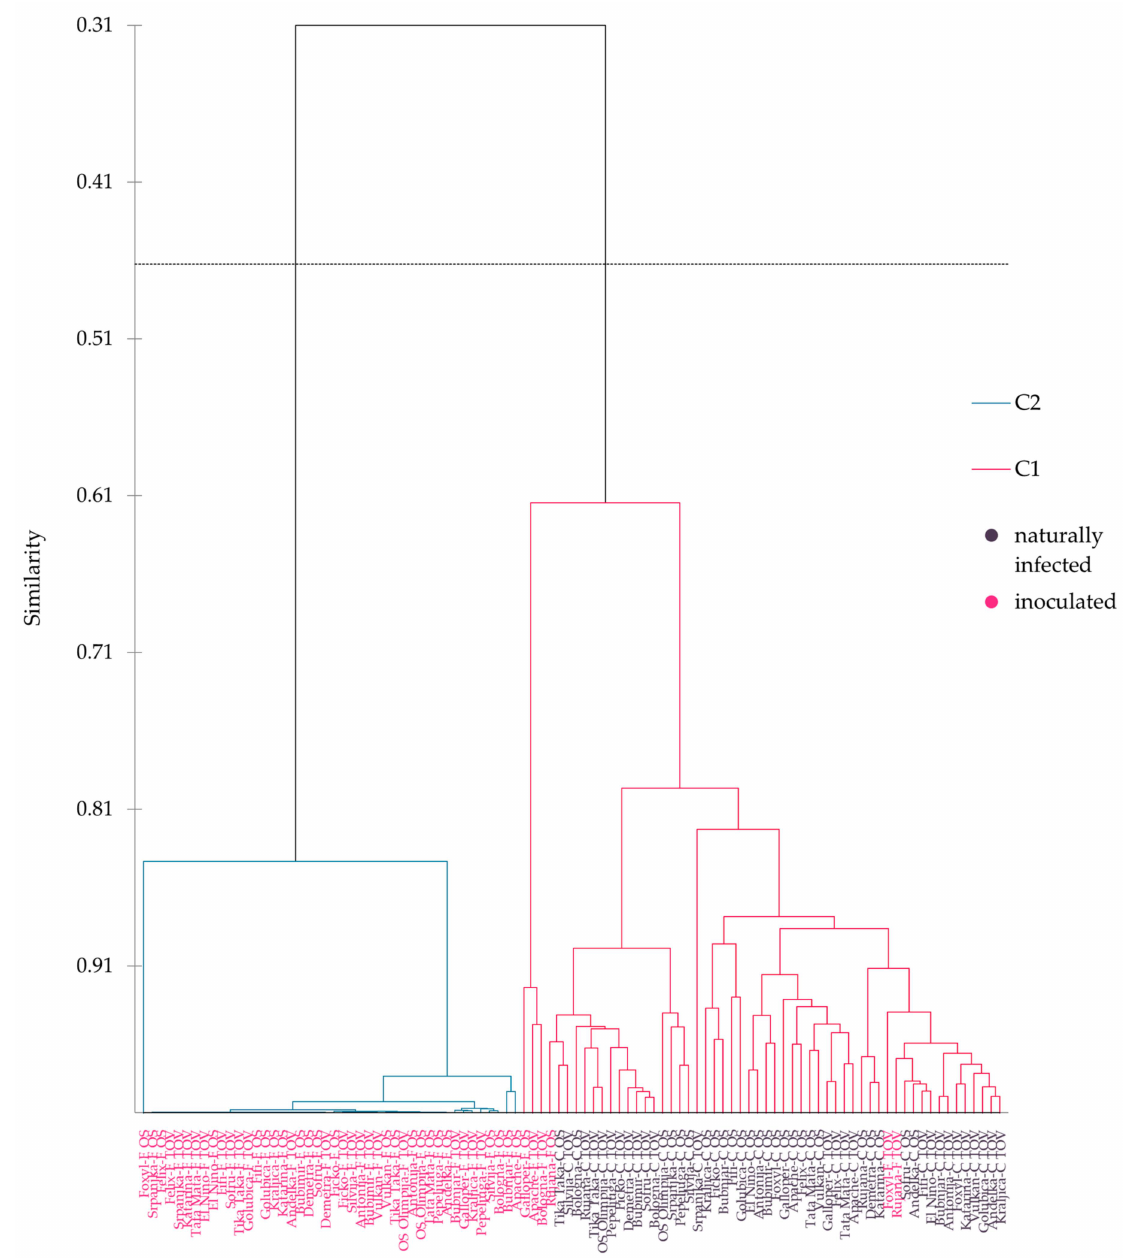
Figure 1. Tree diagram of agglomerative hierarchical clustering of 25 winter wheat varieties based on different grain metabolites and varietal resistance to Fusarium in two treatments (naturally infected or controlled treatment-C and inoculated or Fusarium treated-F) at both locations. Os—Osijek, Tov—Tovarnik, C1—cluster 1, C2—cluster